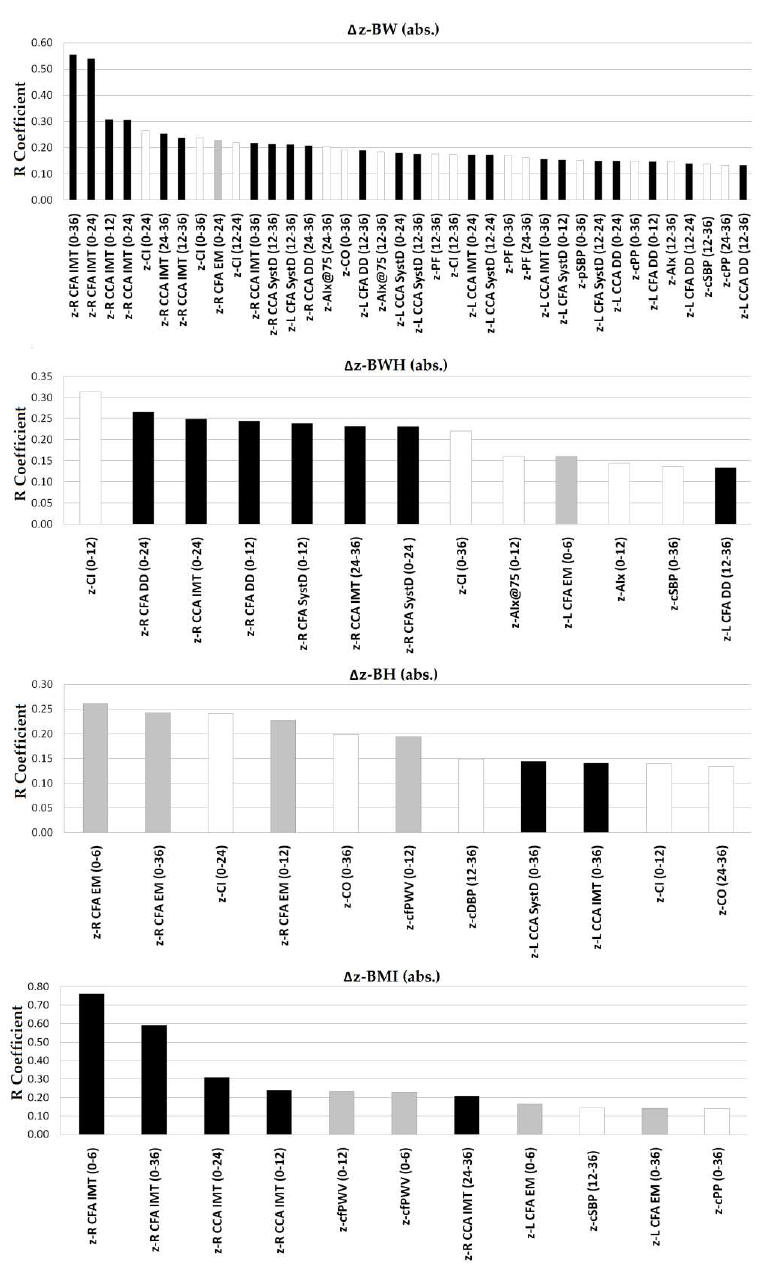
Figure 2. Strength of association (correlation coefficient absolute value, R) between body size changes assessed by anthropometric indexes (Δz-BW, Δz-BWH, Δz-BH, Δz-BMI) and arterial parameter z-scores at age 6 years Black bars: arterial structure parameters; white bars: hemodynamic parameters; and gray bars: arterial stiffness parameters. Numbers in brackets indicate periods in months. Only statistically significant ( p < 0.05) correlations are shown.